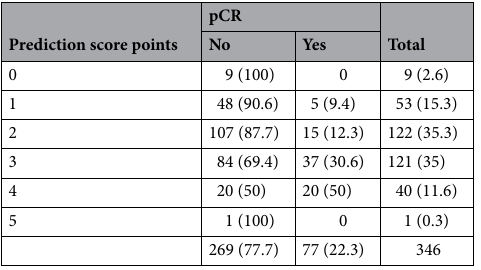
Table 5. The rate of pCR in the derivation cohort. pCR pathologic complete response.